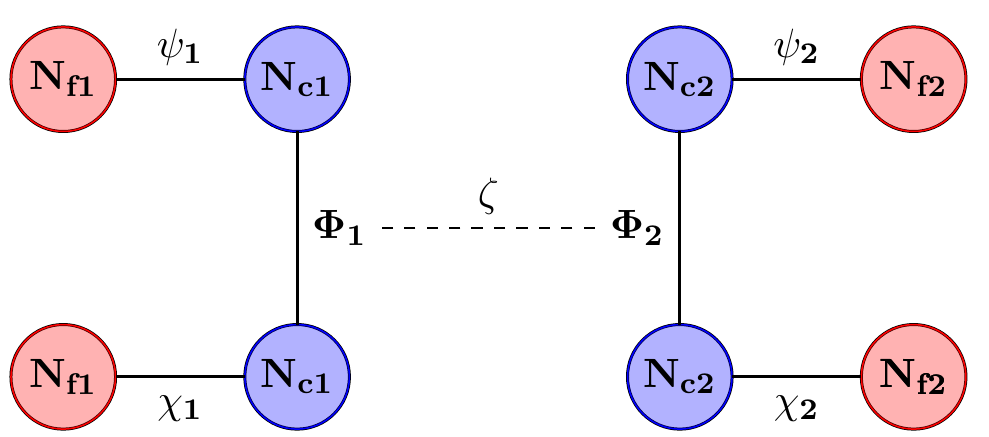
Figure 2. A schematic diagram of the field content of the double bifundamental